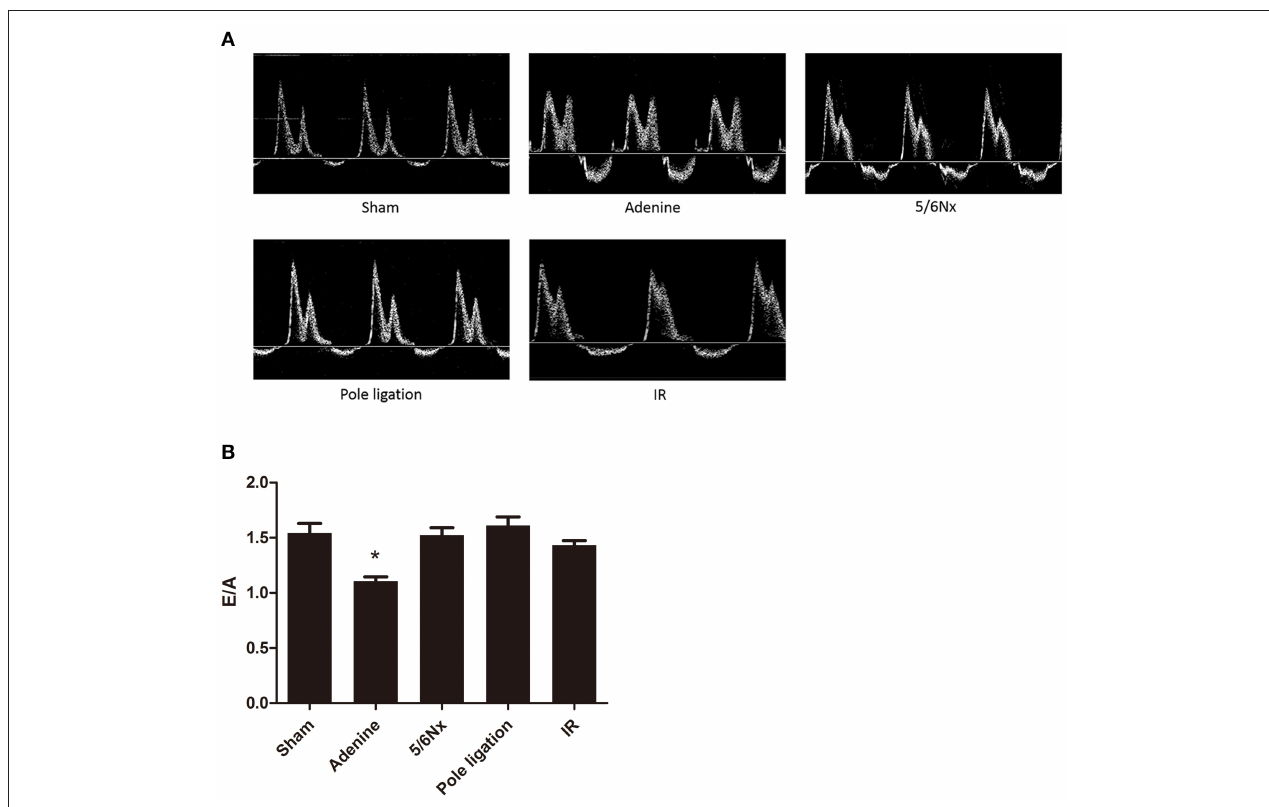
FIGURE 5 | Between-group comparisons of left ventricular diastolic function assessed by echocardiography and Doppler. (A) Representative M-mode echocardiograms from the sham, adenine group, 5/6th nephrectomy group (5/6Nx), pole ligation group, and uninephrectomy plus contralateral ischemia followed by reperfusion group (IR). (B) The mean E/A in the sham, adenine group, 5/6th nephrectomy group (5/6Nx), pole ligation group, and uninephrectomy plus contralateral ischemia followed by reperfusion group (IR). Data are presented as the mean ± SEM ( n = 14–22). * P < 0.001, vs.